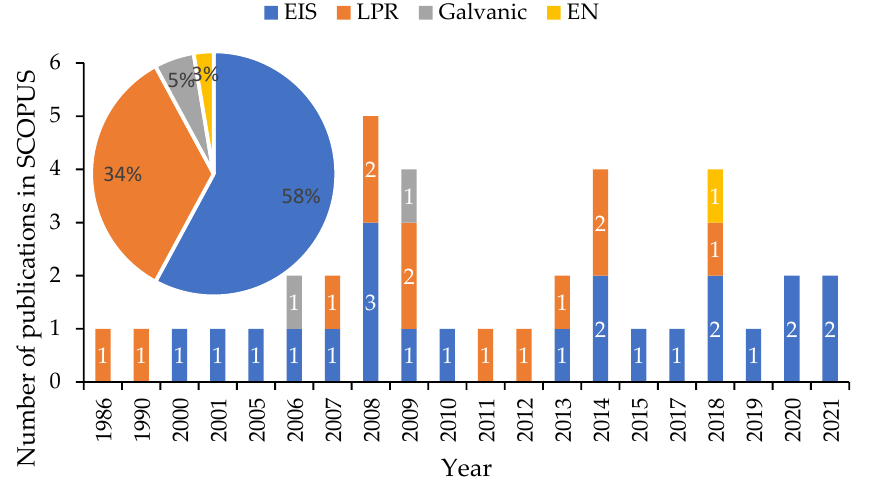
Figure 7. Distribution of the reviewed articles associated with the application of electrochemical methods for corrosion monitoring from 1986 to 2021.